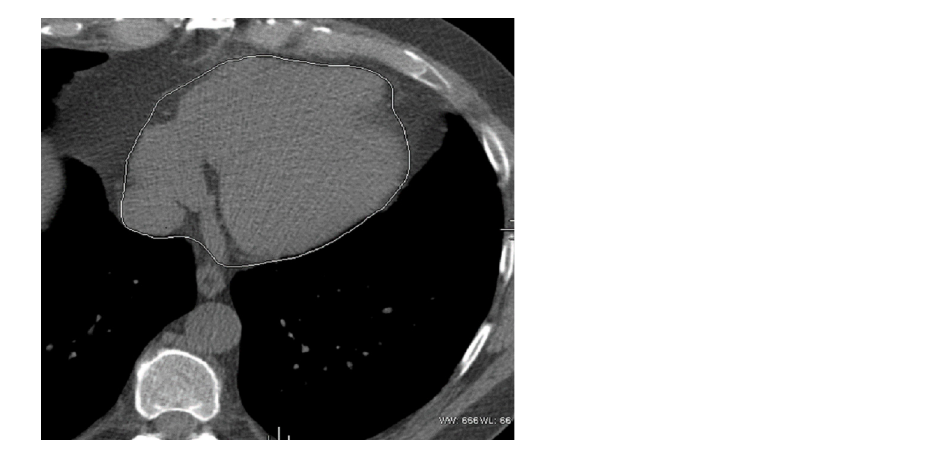
Fig 1. Pericardial Tracing to Define Epicardial Fat